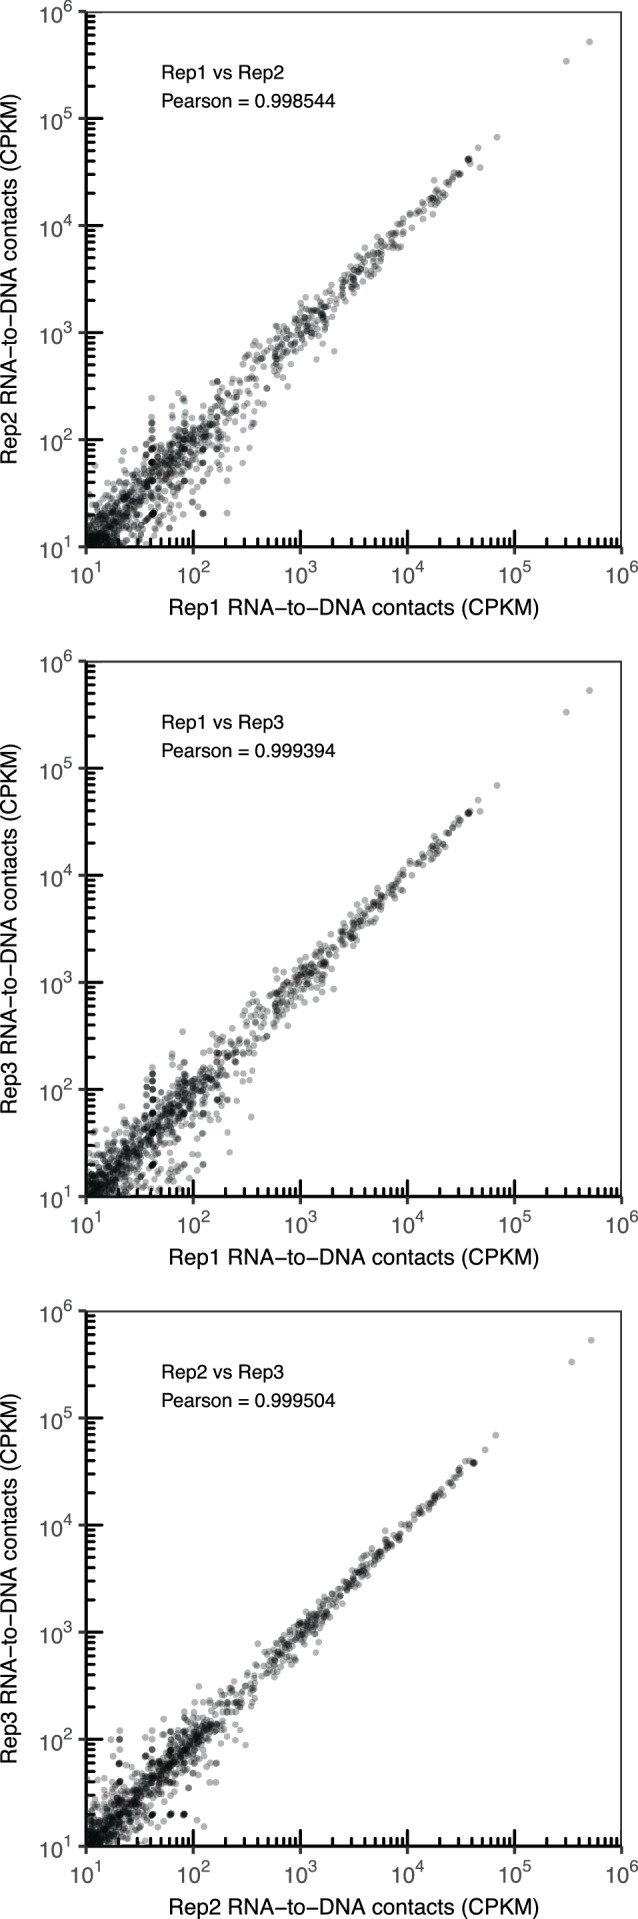
Comparison of RNA-to-DNA contacts between replicates.Scatter plot of the number of contacts for chromatin-associated RNAs identified in CME-W1-cl8+ rep1 vs rep2 (top), rep1 vs rep3 (middle), and rep2 vs rep3 (bottom). Pearson correlation coefficient between each replicate pair is reported.